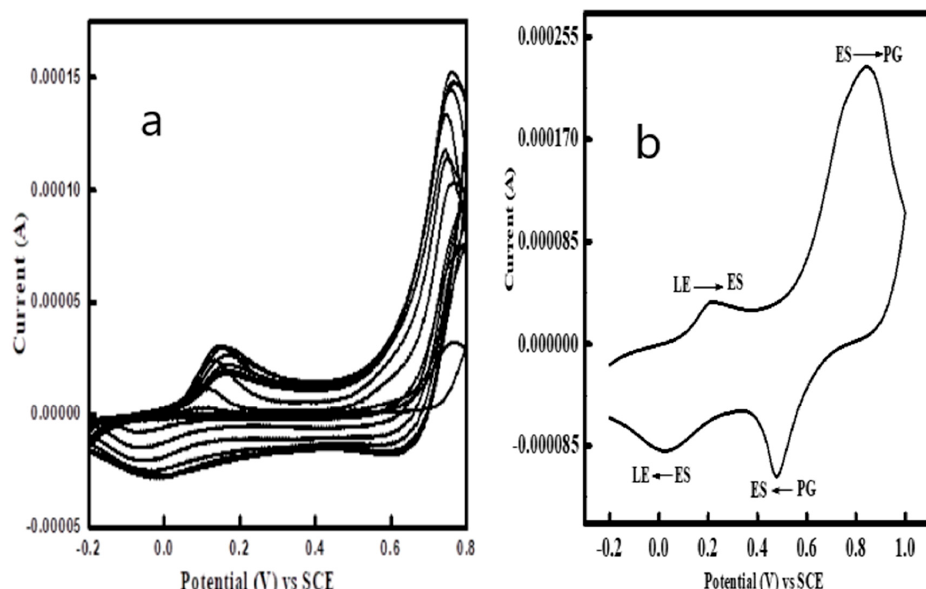
Figure 1. ( a ) Cyclic voltammograms recorded on Au-disc electrode at scan rate of 50 mV / s during polymerization of aniline from an acidic solution containing DBSA. ( b ) Cyclic voltammogram of the PANI film recorded in 1 M sulfuric acid at scan rate of 50 mV / s, indicating the interconversion of PANI film between its reduced leucoemeraldine (LE), semi-oxidized and conducting emeraldine salt (ES) and oxidized pernagraniline (PG) forms.